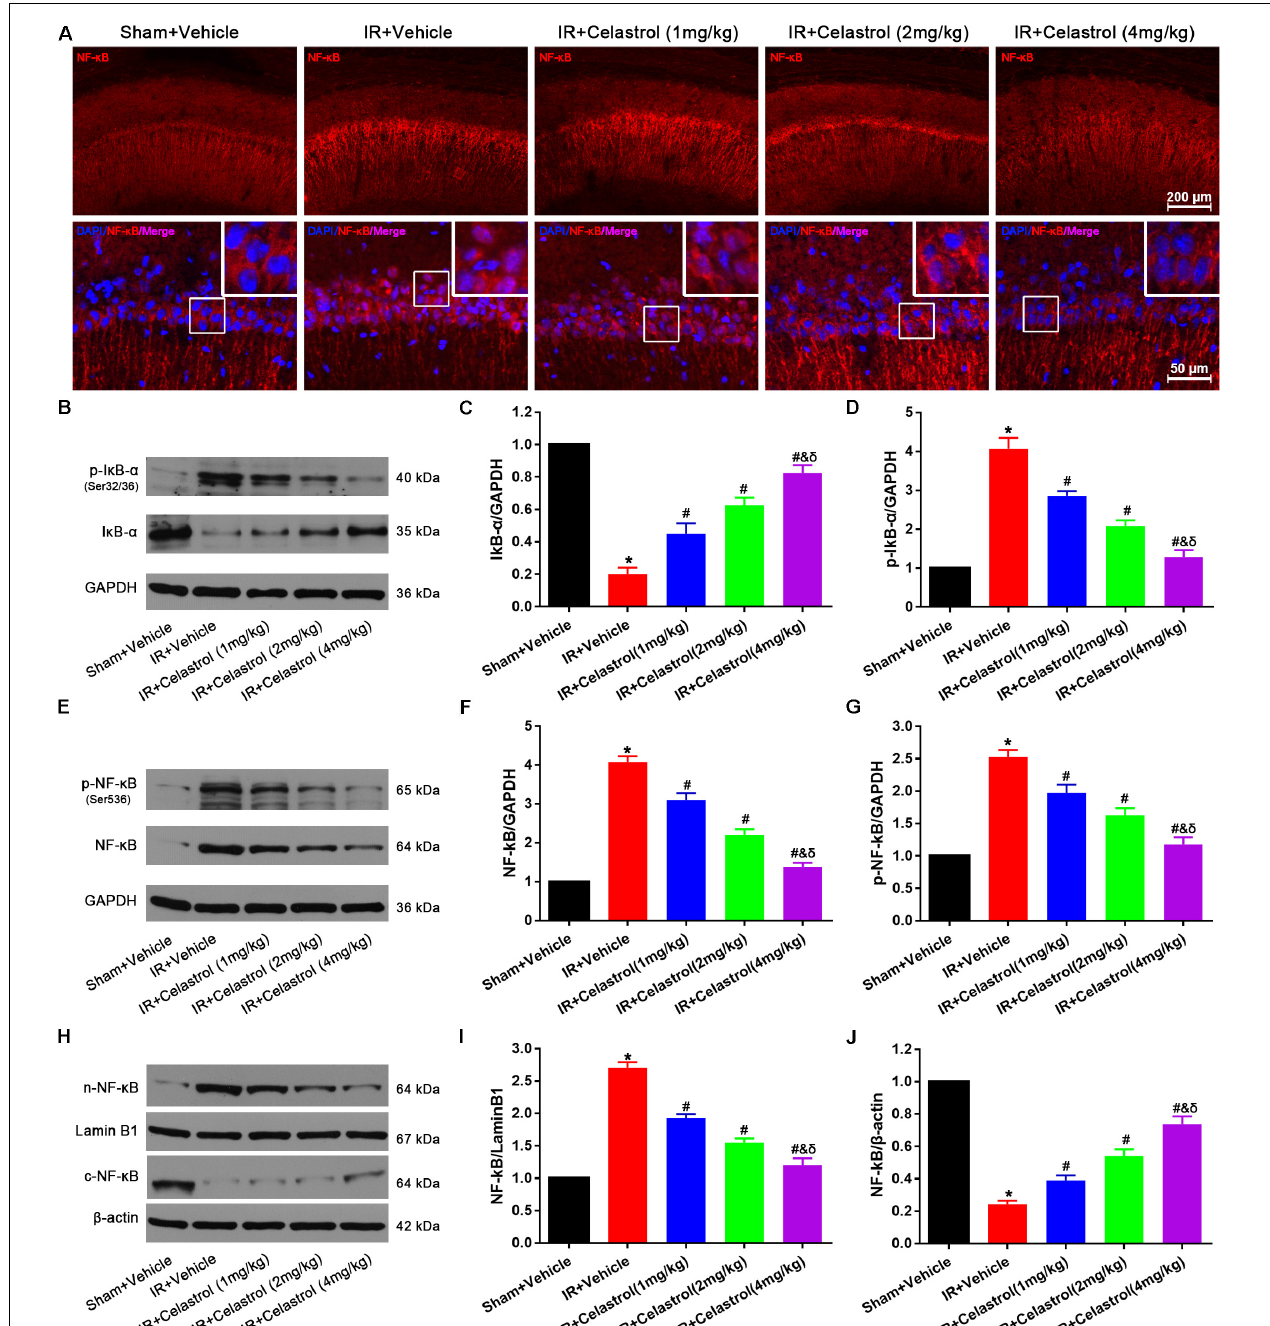
FIGURE 7 | Celastrol inhibited NF- κ B upregulation and nuclei translocation. (A) Representative immunofluorescent images of NF- κ B in the hippocampus 3 days after tGCI/R, celastrol partially rescued tGCI/R induced NF- κ B cytoplasmic-nuclear translocation. The upper right corner built-in thumbnails show the cytoplasmic-nuclear translocation of NF- κ B. Data were obtained from four independent animals, and the results of a typical experiment are presented. Red: NF- κ B, blue: DAPI scale bar = 200 µ m. (B–D) Representative western-blot images and quantitative analysis of I κ B α and phosphorylated I κ B α in the hippocampus 3 days after tGCI/R. (E–G) Representative western-blot images and quantitative analysis of total NF- κ B and phosphorylated NF- κ B in the hippocampus 3 days after tGCI/R. (H–J) Representative western-blot images and quantitative analysis of nuclear and cytoplasmic NF- κ B in the hippocampus 3 days after tGCI/R. The error bars represent mean ± SEM ( n = 4, * P < 0.05 vs. Sham + Vehicle group; # P < 0.05 vs. IR+ Vehicle group; & P < 0.05 vs. IR + Celastrol (1 mg/kg) group; δ P < 0.05 vs. IR + Celastrol (2 mg/kg) group).